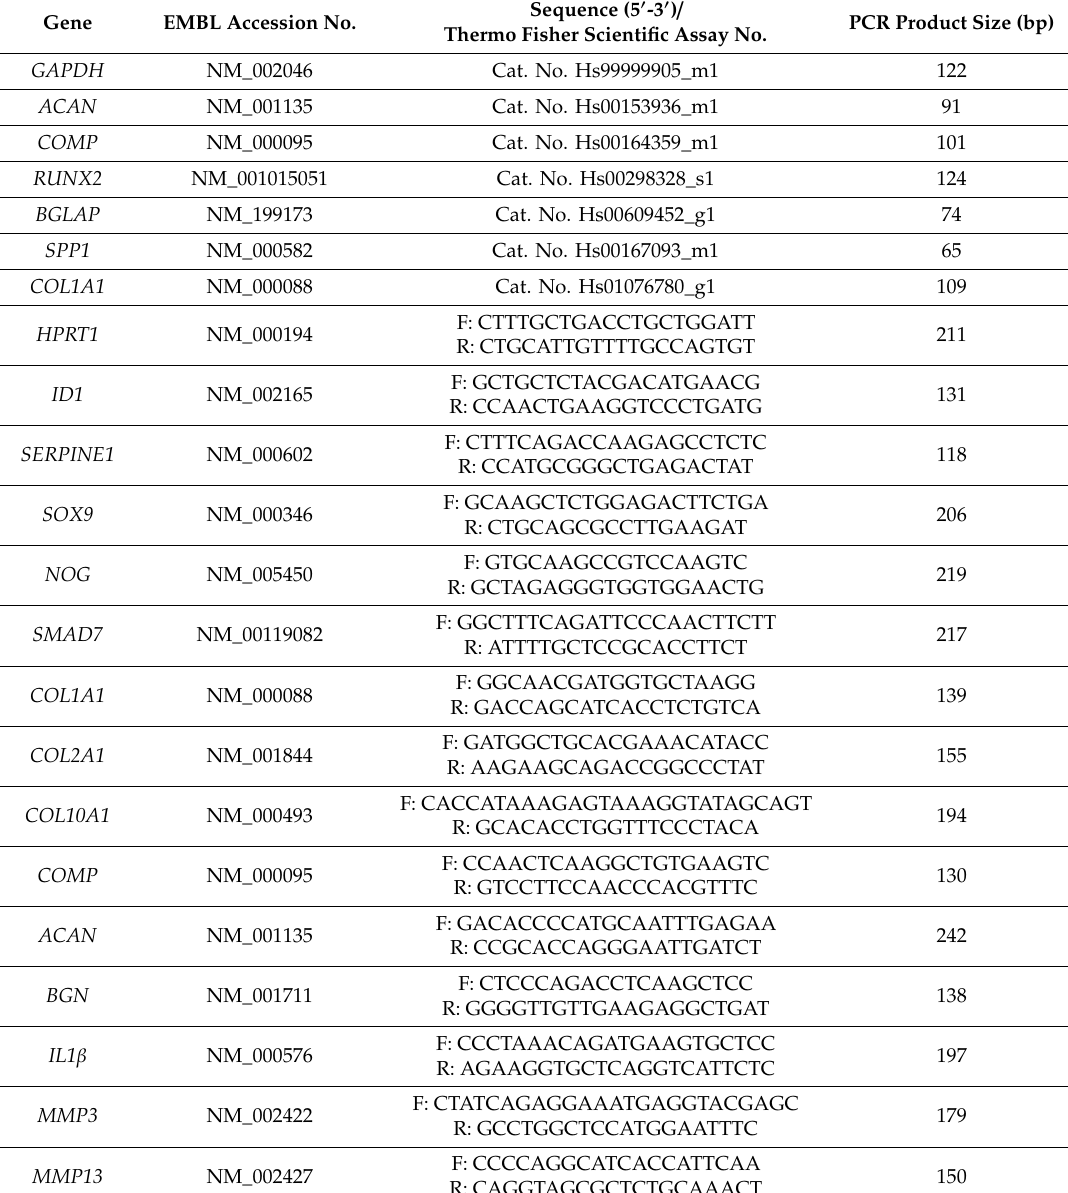
Table 2. Gene accession numbers, TaqMan assay numbers or primer sequences, and expected transcript lengths used for the detection of gene